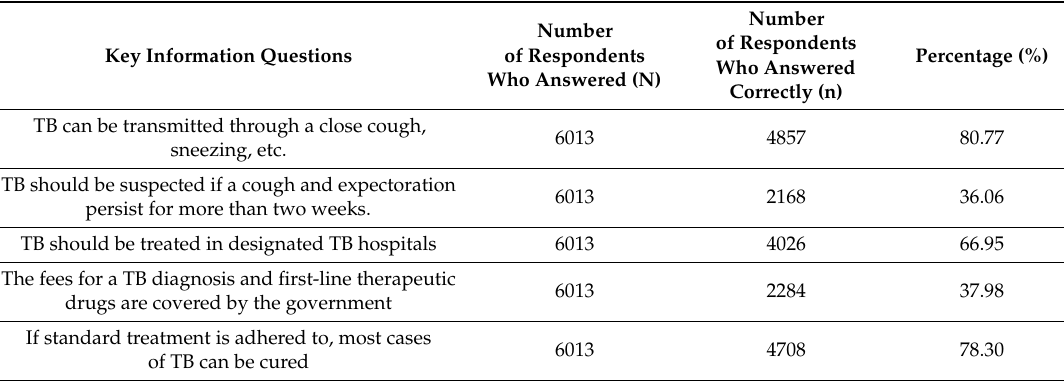
Table 5. Rate of awareness of each piece of key information about TB among the respondents in